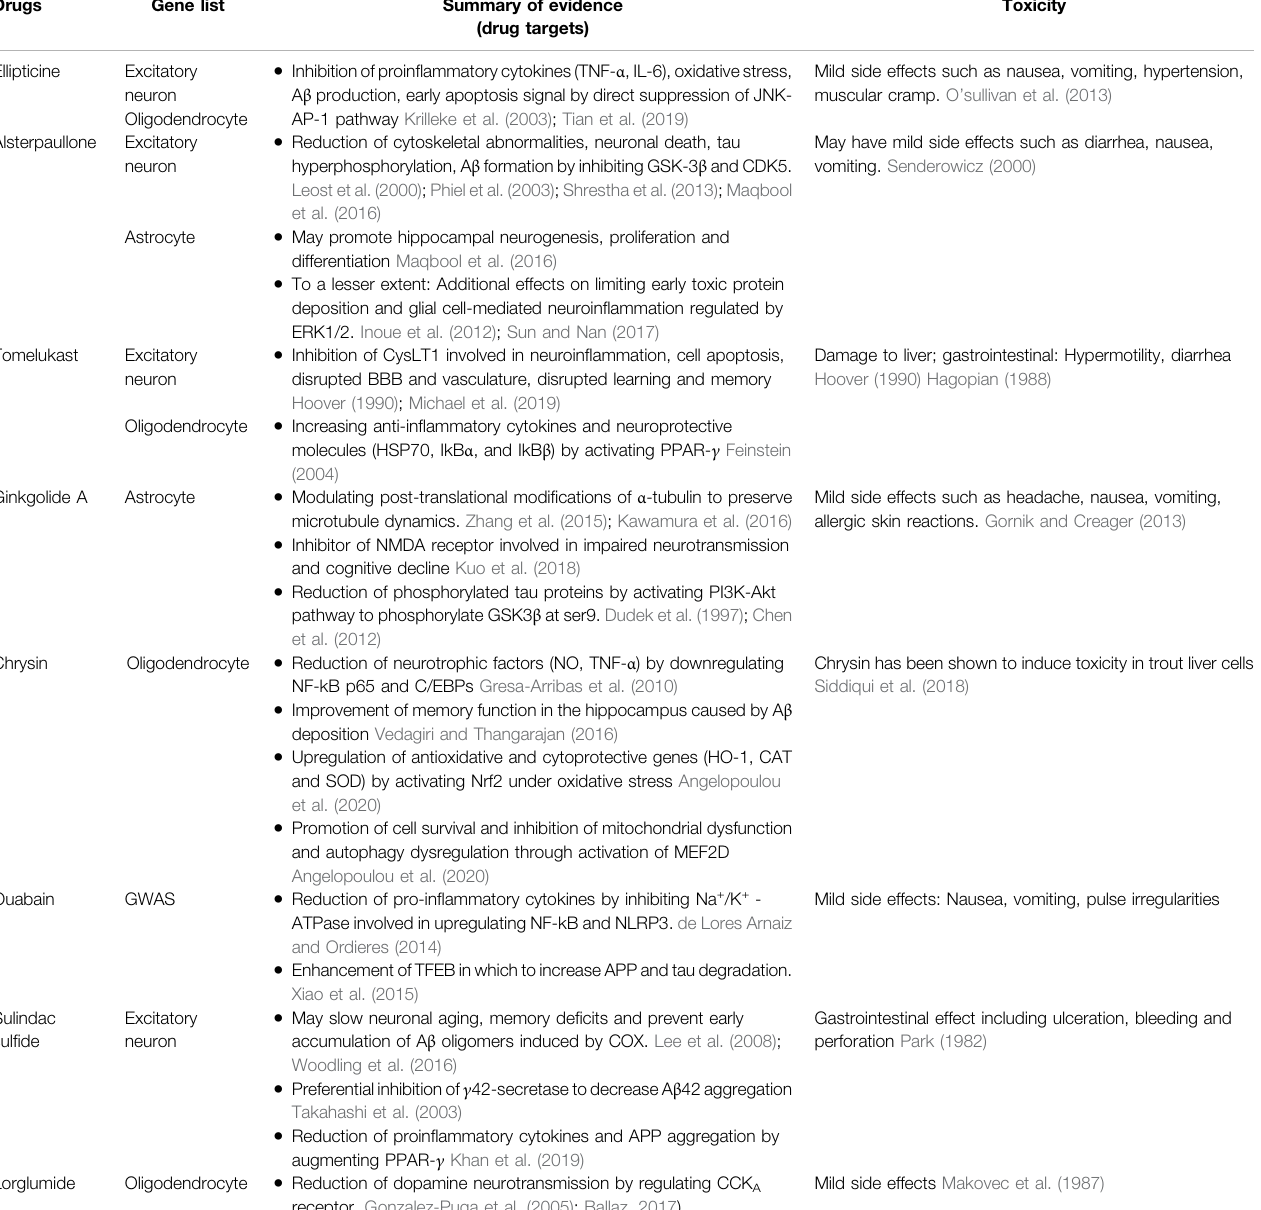
TABLE 2 | Summary of literature evidence for prioritized drugs obtained from Gene2Drug analysis. Drugs Gene list Summary of evidence (drug